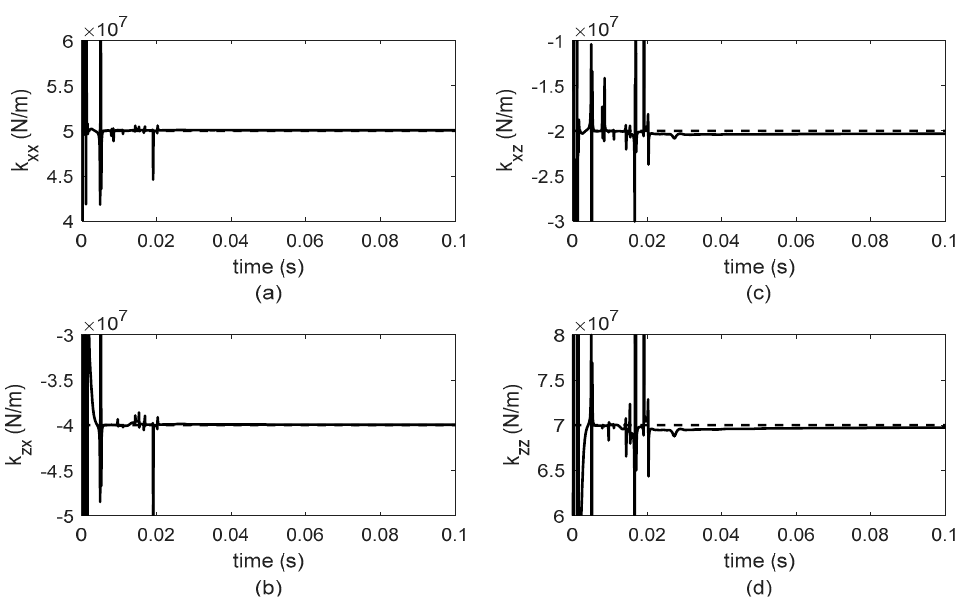
Figure 7. Identified stiffness parameters for bearing 2 at 600 rpm. ( a ) k xx , ( b ) k xz , ( c ) k zx , ( d ) k zz .